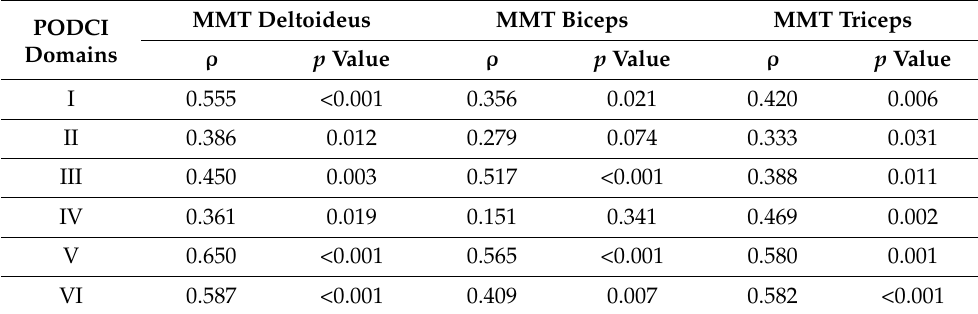
Table 2. Construct validity correlations between Serbian version of PODCI and the Manual muscu- lar